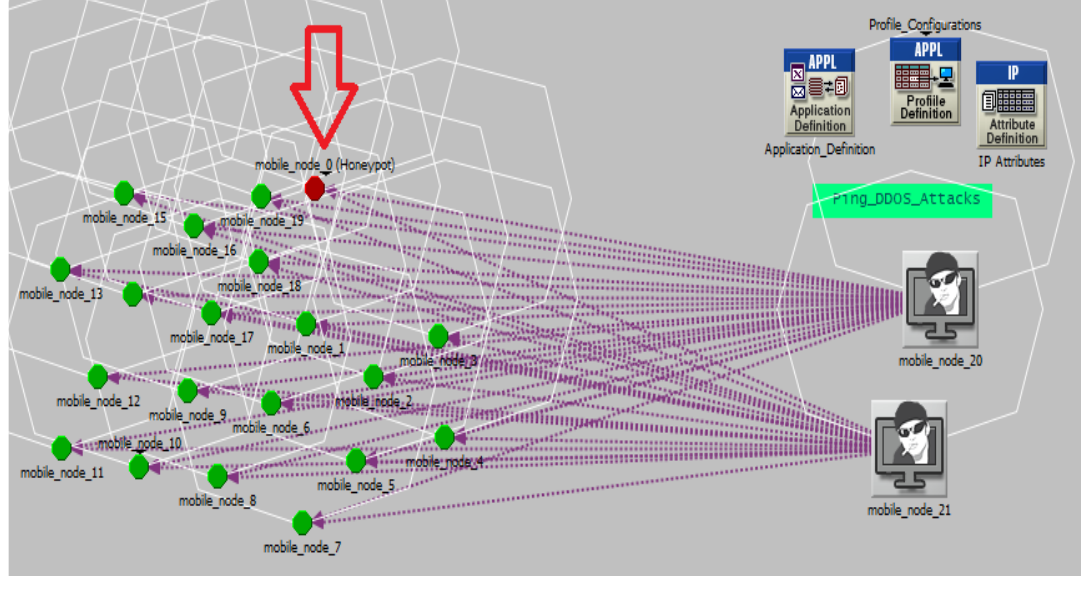
Fig. 2. Honeypot Simulation.